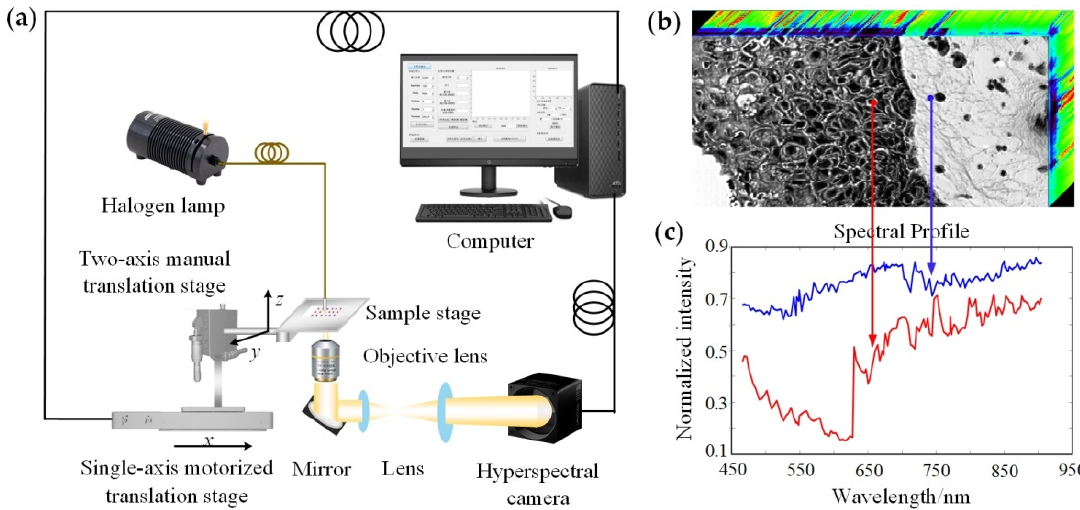
Figure 1. HMI system and data analysis. ( a ) Schematic diagram of the push-broom HMI system; ( b ) HMI data cube; ( c ) spectral profiles corresponding to the marked points in ( b ), the red and blue spectral curves corresponded to the red and blue points, respectively.